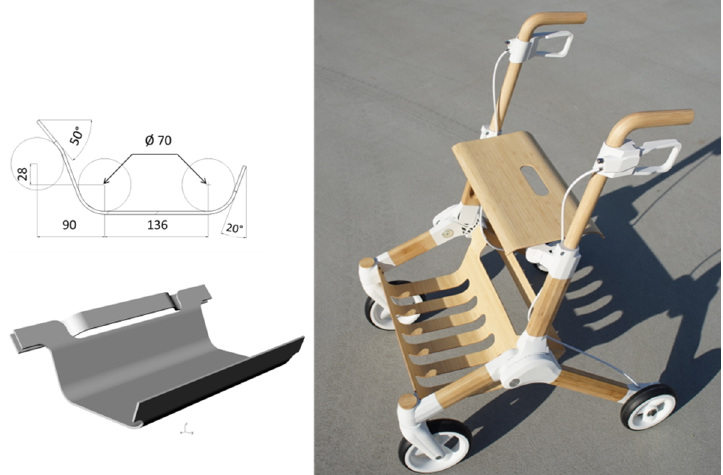
Figure 1. Bambulator—form parts.